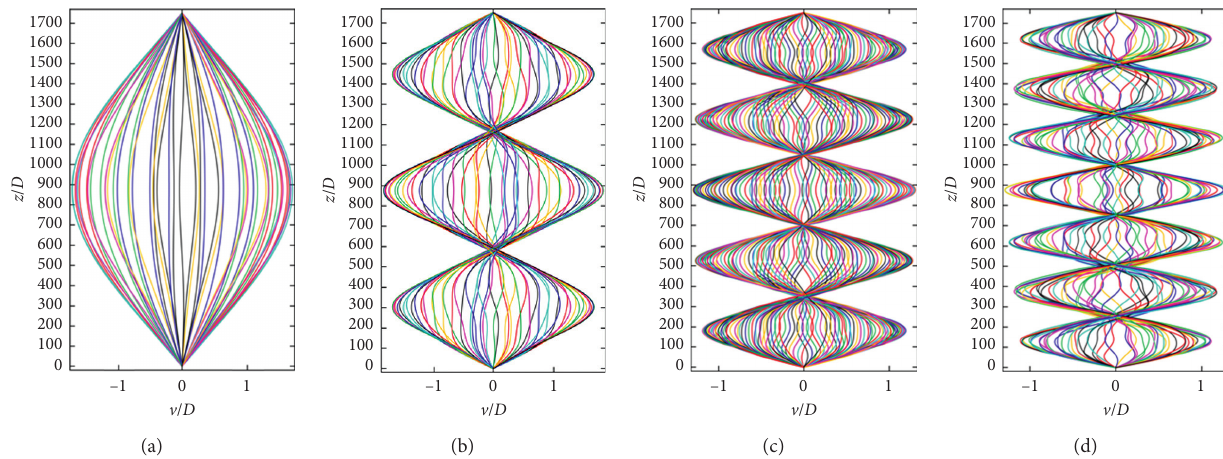
Figure 3: The variations of the cross-flow vibration pattern of the marine riser with different sea water flow speed for (a) U � 0 . 1m/s, (b) U � 0 . 3m/s, (c) U � 0 . 5m/s, and (d) U � 1 . 0m/s.